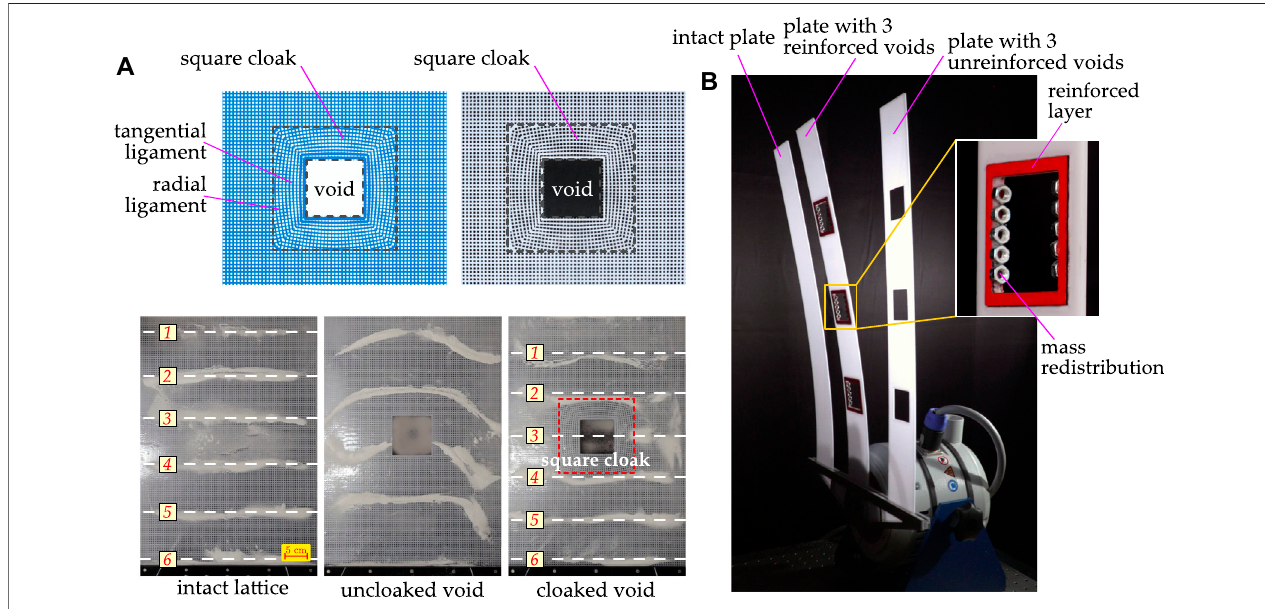
FIGURE 1 | (A) Experimental implementation of a square cloak embedded in a square lattice (Misseroni et al., 2016). (top) Geometrical model implemented in Abaqus and its comparison with physical model realized by milling a Polycarbonate plate. (bottom) Dynamic response for an applied frequency of 120 Hz. The nodal lines(white/dashedlines)oftheintactlatticeandthelatticewiththecloakedvoidalmostcoincideanddiffersfromthoseofthelatticewiththeuncloakedvoid. (B) Cloaking systembasedonthereinforcementoftheboundaryandtheredistributionofthemass(Misseronietal.2019).Asinusoidaldisplacementisappliedatthebaseofthe plates. The dynamic response of the intact plate and the plate with the reinforced voids is the same and it is different from that of the plate with the unreinforced